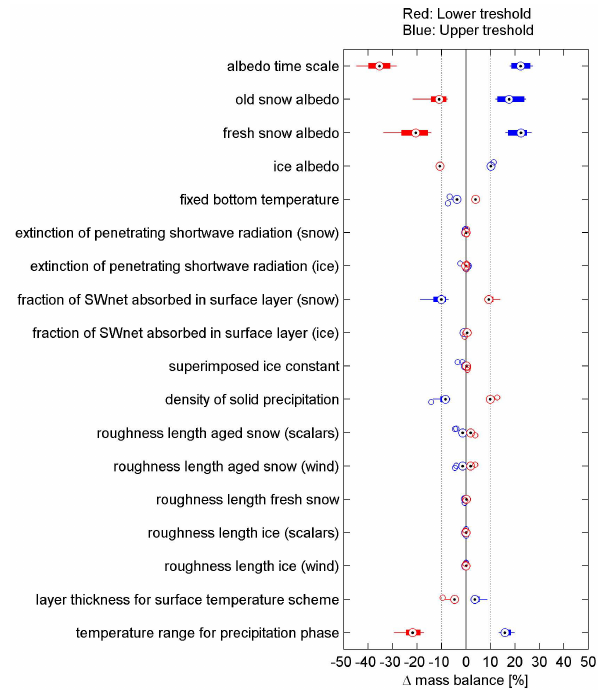
Fig. 3. Sensitivity of modeled mass balance to the selected free model parameters set to their upper/lower limit compared to the re- sults obtained with median values for all parameters at each of the 20 model points framing the stake locations. Points show the me- dian values, the edge of the horizontal bars show the 25% and 75% percentiles, the whiskers extend to the extremes not considered as outliers and the outliers are plotted as small